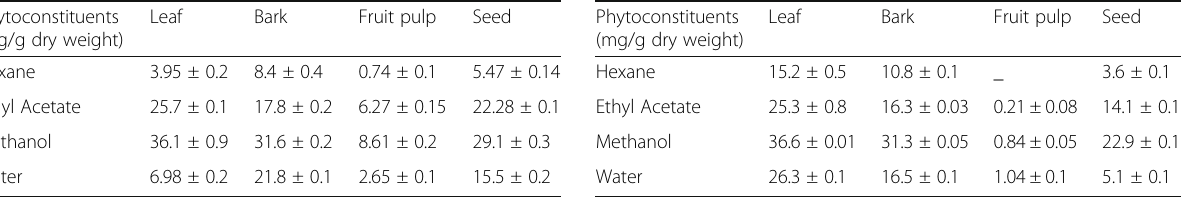
Table 1 The quantitative estimation of total phenol content of the different solvent extracts of S. caryophyllatum leaf, bark fruit pulp and seed Phytoconstituents (mg/g dry weight)